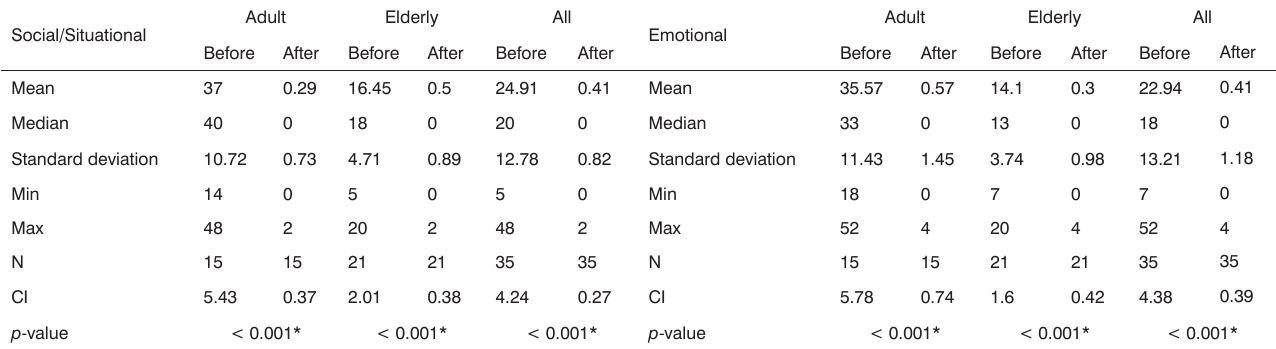
Table 1. Comparison of findings from HHIA and HHIE-S scales before and one month after hearing aid fitting. Adult Elderly All Adult Elderly All Social/Situational Emotional Before After Before After Before After Before After Before After Before After